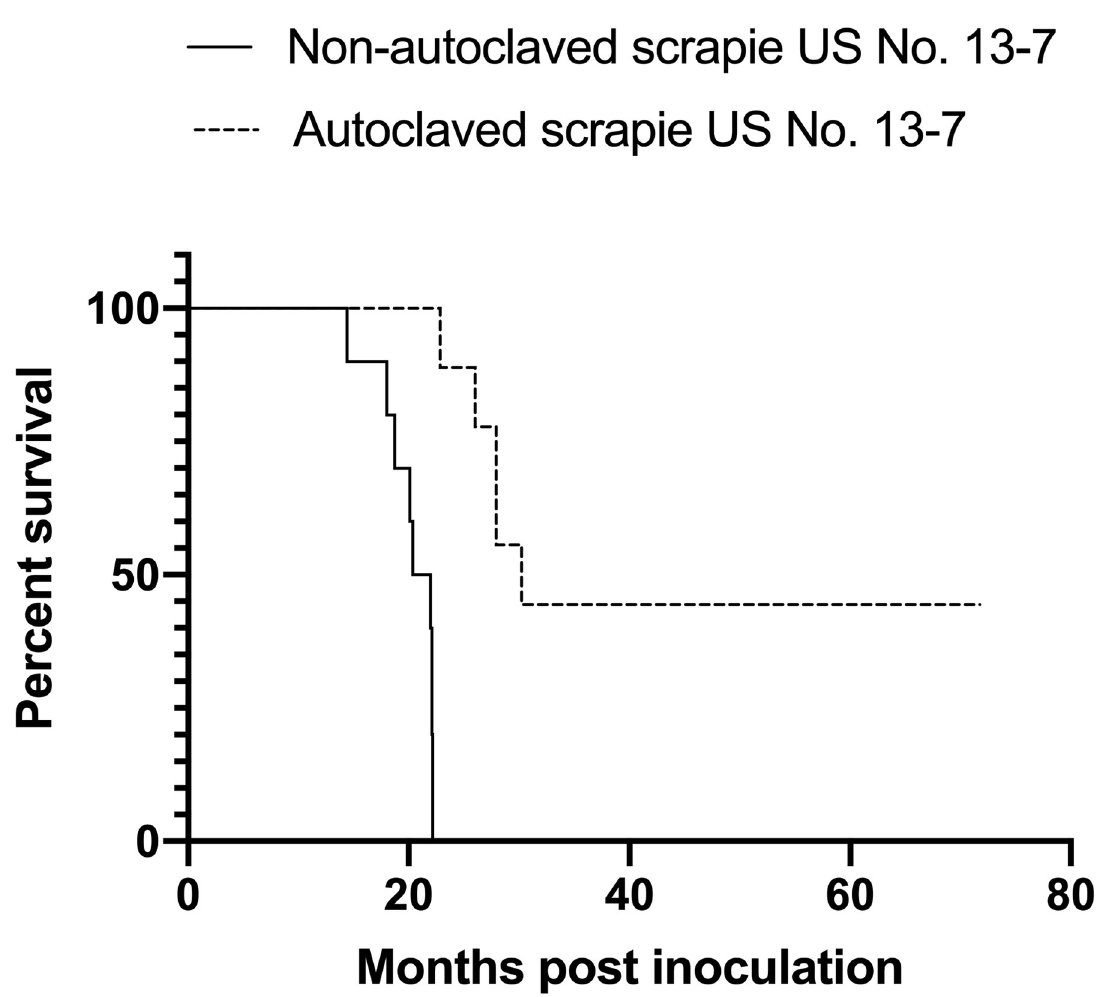
Fig 1. Death events in sheep inoculated via the oral route with either non-autoclaved or autoclaved scrapie agent US No. 13–7. Percent survival graph showing a significant difference (p < 0.0001, Gehan-Breslow-Wilcoxon test) between survival